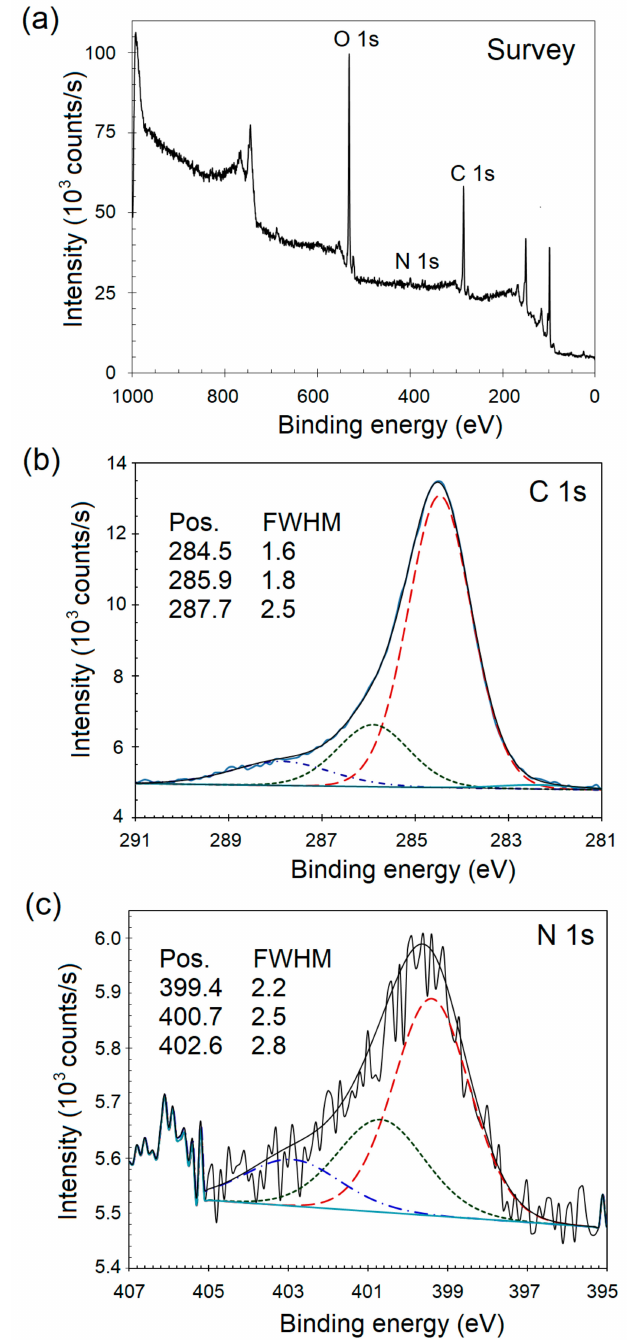
Figure 1. ( a ) XPS survey spectrum of the electrochemically grafted para-nitrobenzene diazonium (PNBD) and high resolution valence band regions with component peaks for ( b ) the C 1s and ( c ) the N 1s